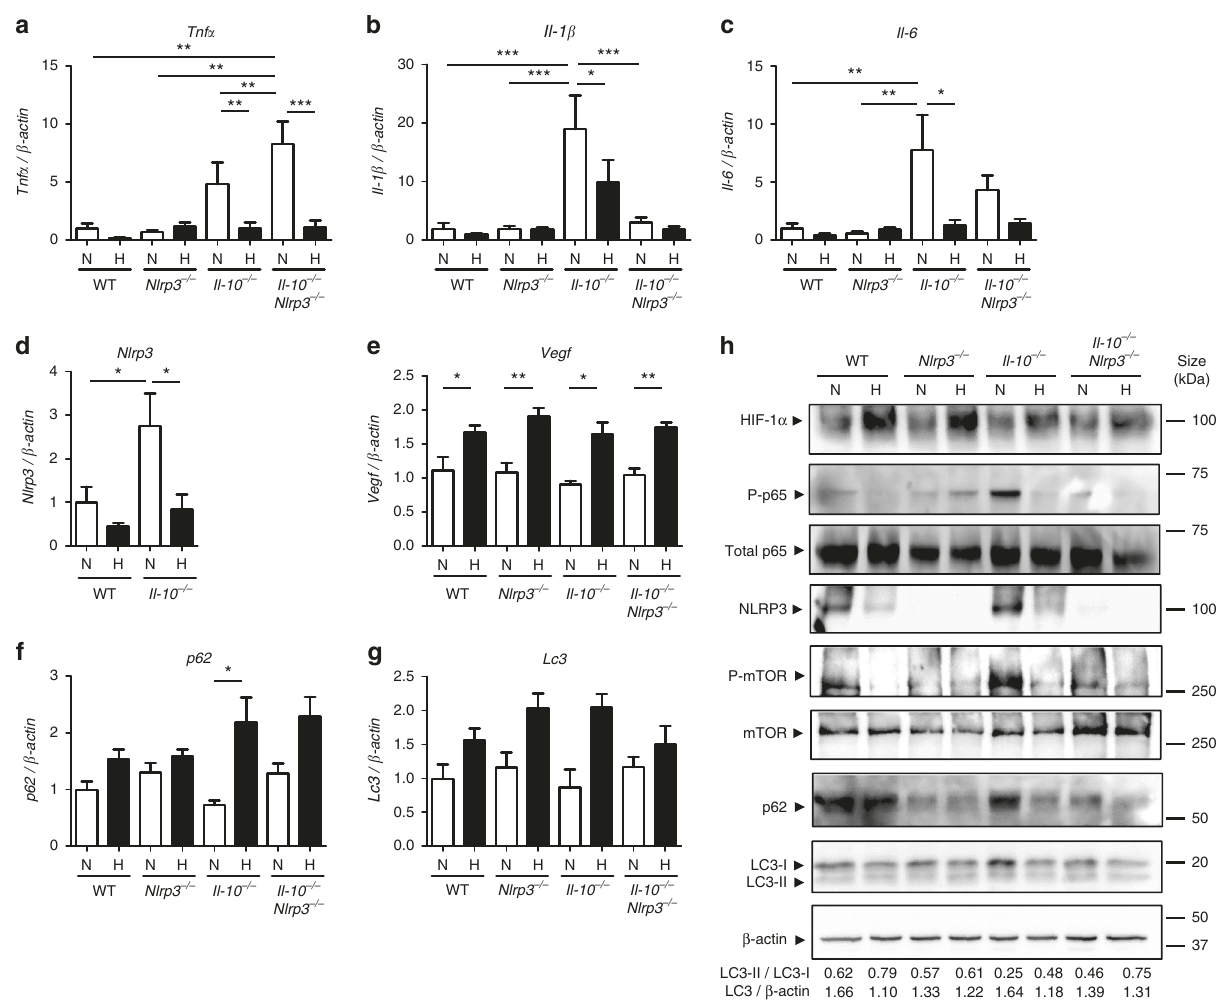
Fig. 3 Hypoxia reduces in fl ammatory processes and induces autophagy in Il-10 − / − mice. a , b , c , d , e , f and g WT, Nrlp3 − / − , Il-10 − / − , and Il-10 − / − Nrlp3 − / − double knockout mice were subjected to normoxia ( N , 21% O 2 ) or hypoxia ( H , 8% O 2 ). After 18 h, mice were killed and colon biopsies were collected. Statistical analysis was performed using one-way ANOVA followed by Tukey ’ s post-test. Results represent mean + s.e.m., WT mice under normoxia: n = 5, WT mice under hypoxia: n = 5; Nrlp3 − / − mice under normoxia: n = 4; Nrlp3 − / − mice under hypoxia: n = 5; Il-10 − / − mice under hypoxia: n = 4; Il-10 − / − mice under hypoxia: n = 4; Il-10 − / − Nrlp3 − / − mice under normoxia: n = 7; Il-10 − / − Nrlp3 − / − mice under hypoxia: n = 9, * P < 0.05; ** P < 0.01; *** P < 0.001. h Total protein was isolated and western blot performed. LC3-I and LC3-II bands were quanti fi ed, and autophagy was measured by variations in the ratio of LC3-II/LC3-I and the total amount of LC3 (LC3-I plus LC3-II) relative to β